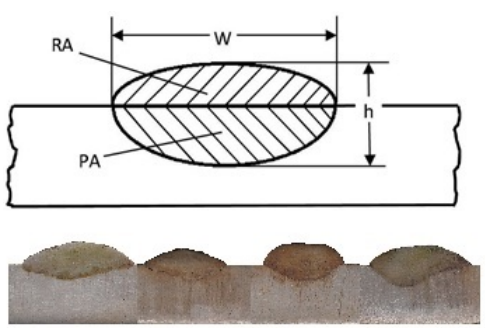
Table 2: Chemical composition of base plate